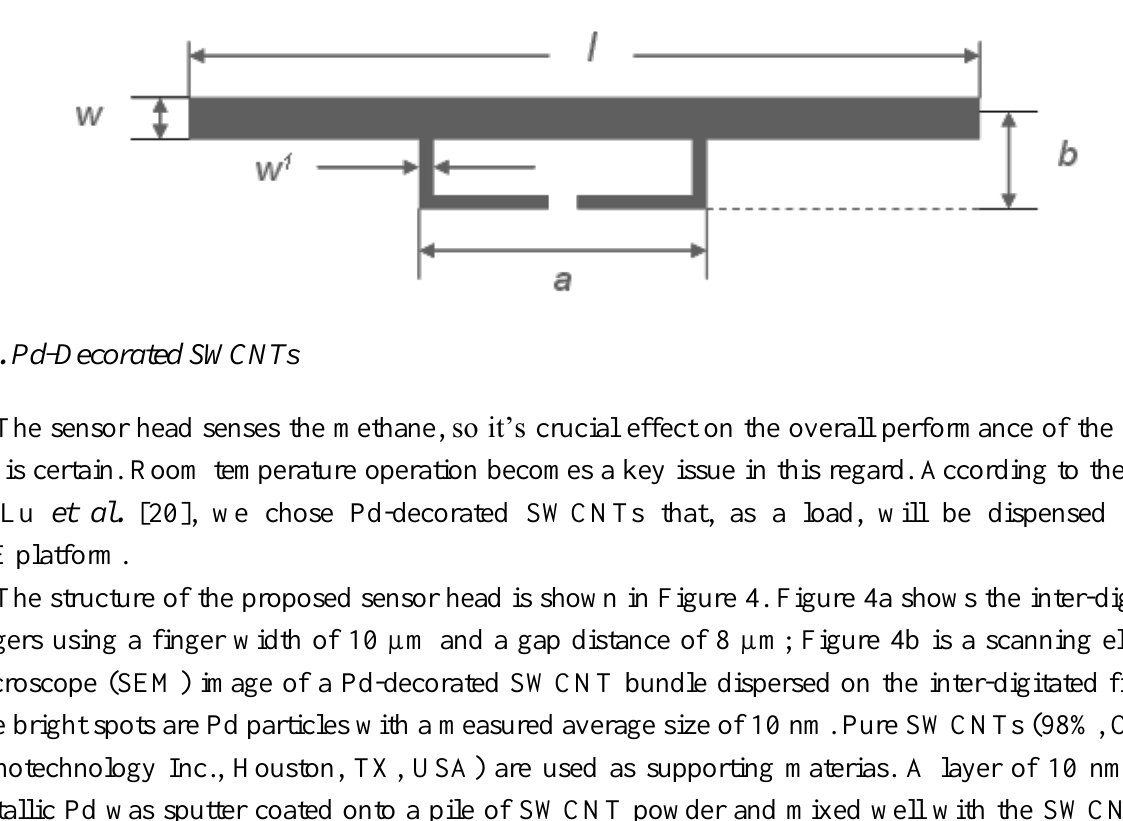
Figure 3. Illustration of the dimensions of the antenna